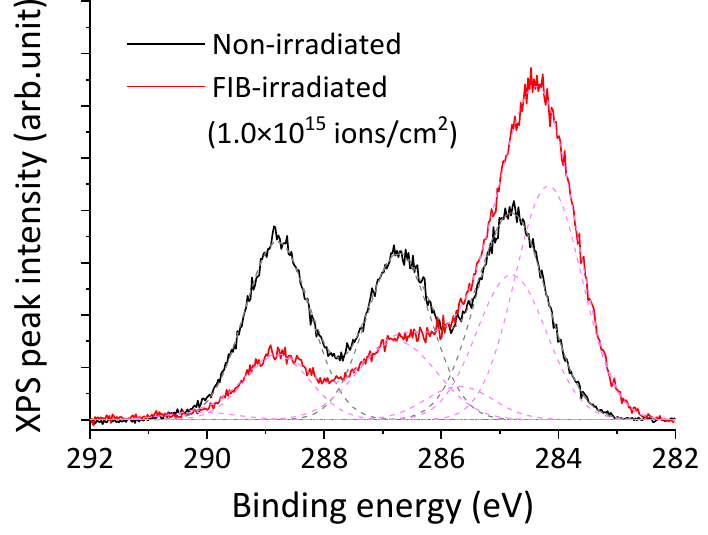
Figure 2. X-ray photoelectron spectroscopy (XPS) spectra of C 1 s in non-irradiated and focused ion beam (FIB)-irradiated (1.0 × 10 15 ions / cm 2 ) poly(L-lactic acid)